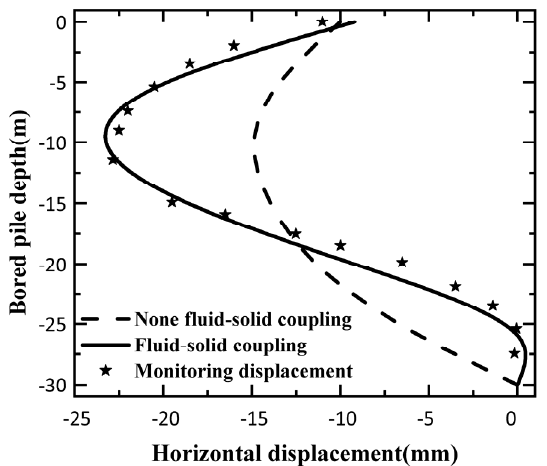
Figure 2. Comparison of calculated and measured values of horizontal displacement of bored